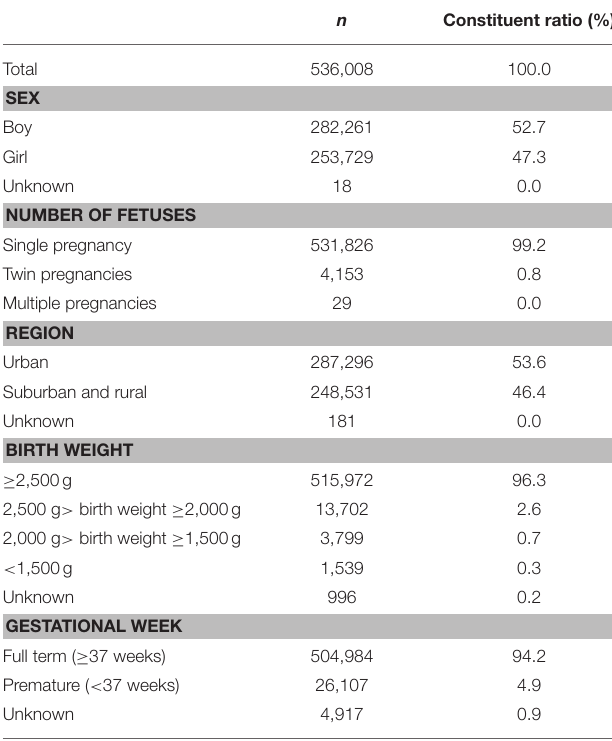
TABLE 1 | Baseline characteristics of all